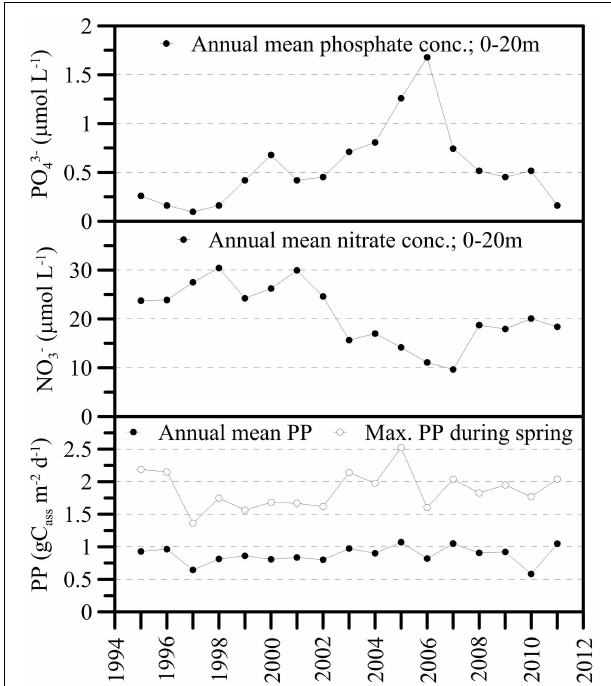
FIGURE 5 | Annual mean nutrient concentrations (PO 4 -P, NO − 3 -N) in the upper water column (0–20m) and long-term trends for gross primary production (GPP in g C assimilated per m 2 per day). GPP data are given as annual mean values and maximum C assimilation rates during the spring bloom. In association with the holomixis events in 2005 and 2006, and the internal redistribution of nutrients, photic zone PO 4 -P concentrations increased strongly. NO − 3 concentrations decreased slightly between 2004 and 2007. The primary production data did not reveal any significant perturbation of lake productivity in immediate response to the changed nutrient availability in surface water.